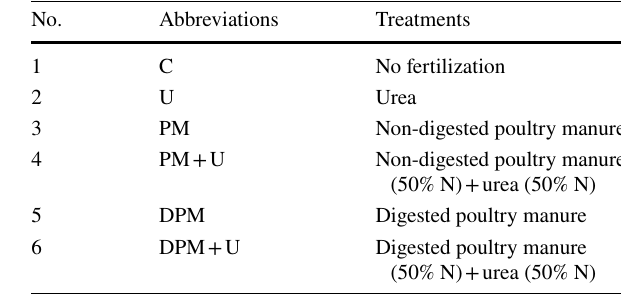
Table 2 Physical and chemical characteristics of non-digested and digested poultry manure used in germination experiment Parameters Non-digested manure